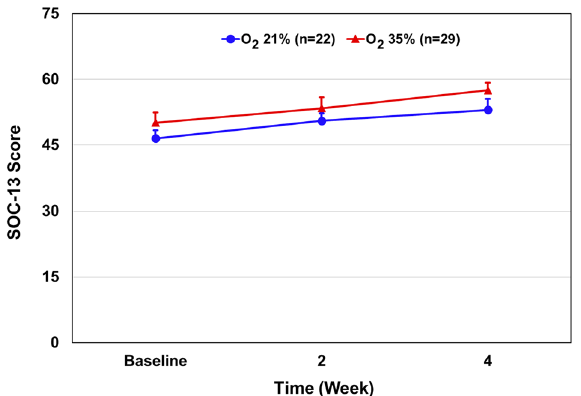
Figure 5. Effect of 35% oxygen treatment on SOC-13 score. Results are presented as mean ± SEM. Multivariate regression analysis: The mean ± SD changes in the scores from baseline to week four were 7.2 ± 3.7 points in the oxygen-treated group and 6.2 ± 2.9 in the control group, for a between-group difference of 0.97 points (95% CI − 3.18 to 9.99; P = 0.303).